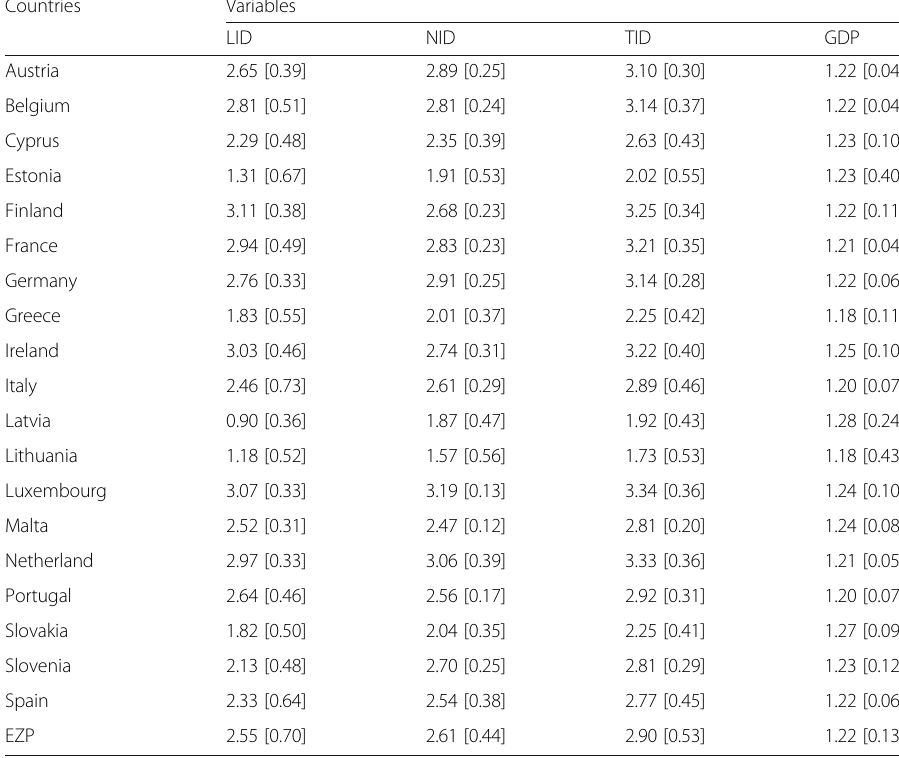
Table 1 Descriptive Statistics of Variables